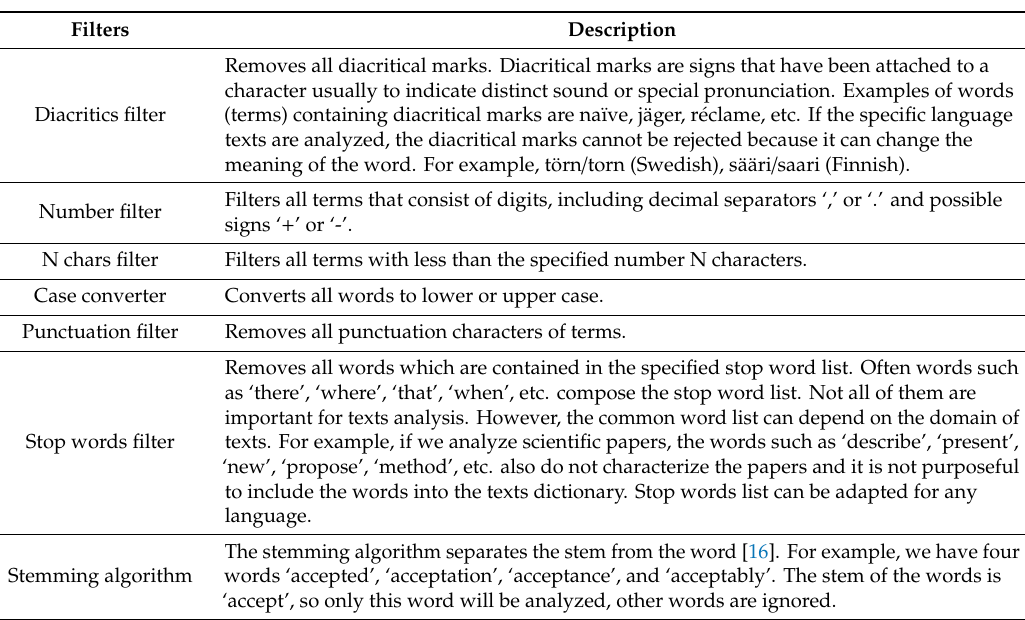
Table 1. Descriptions of